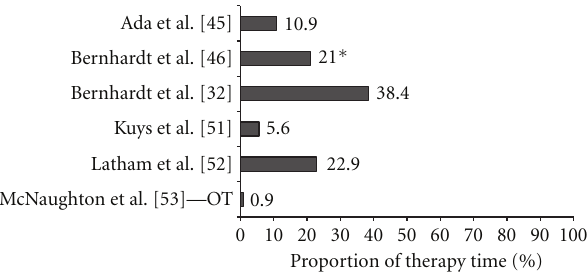
Figure 6: Upper limb therapy. ∗ A ff ected upper limb use across physiotherapy, occupational therapy, and speech therapy